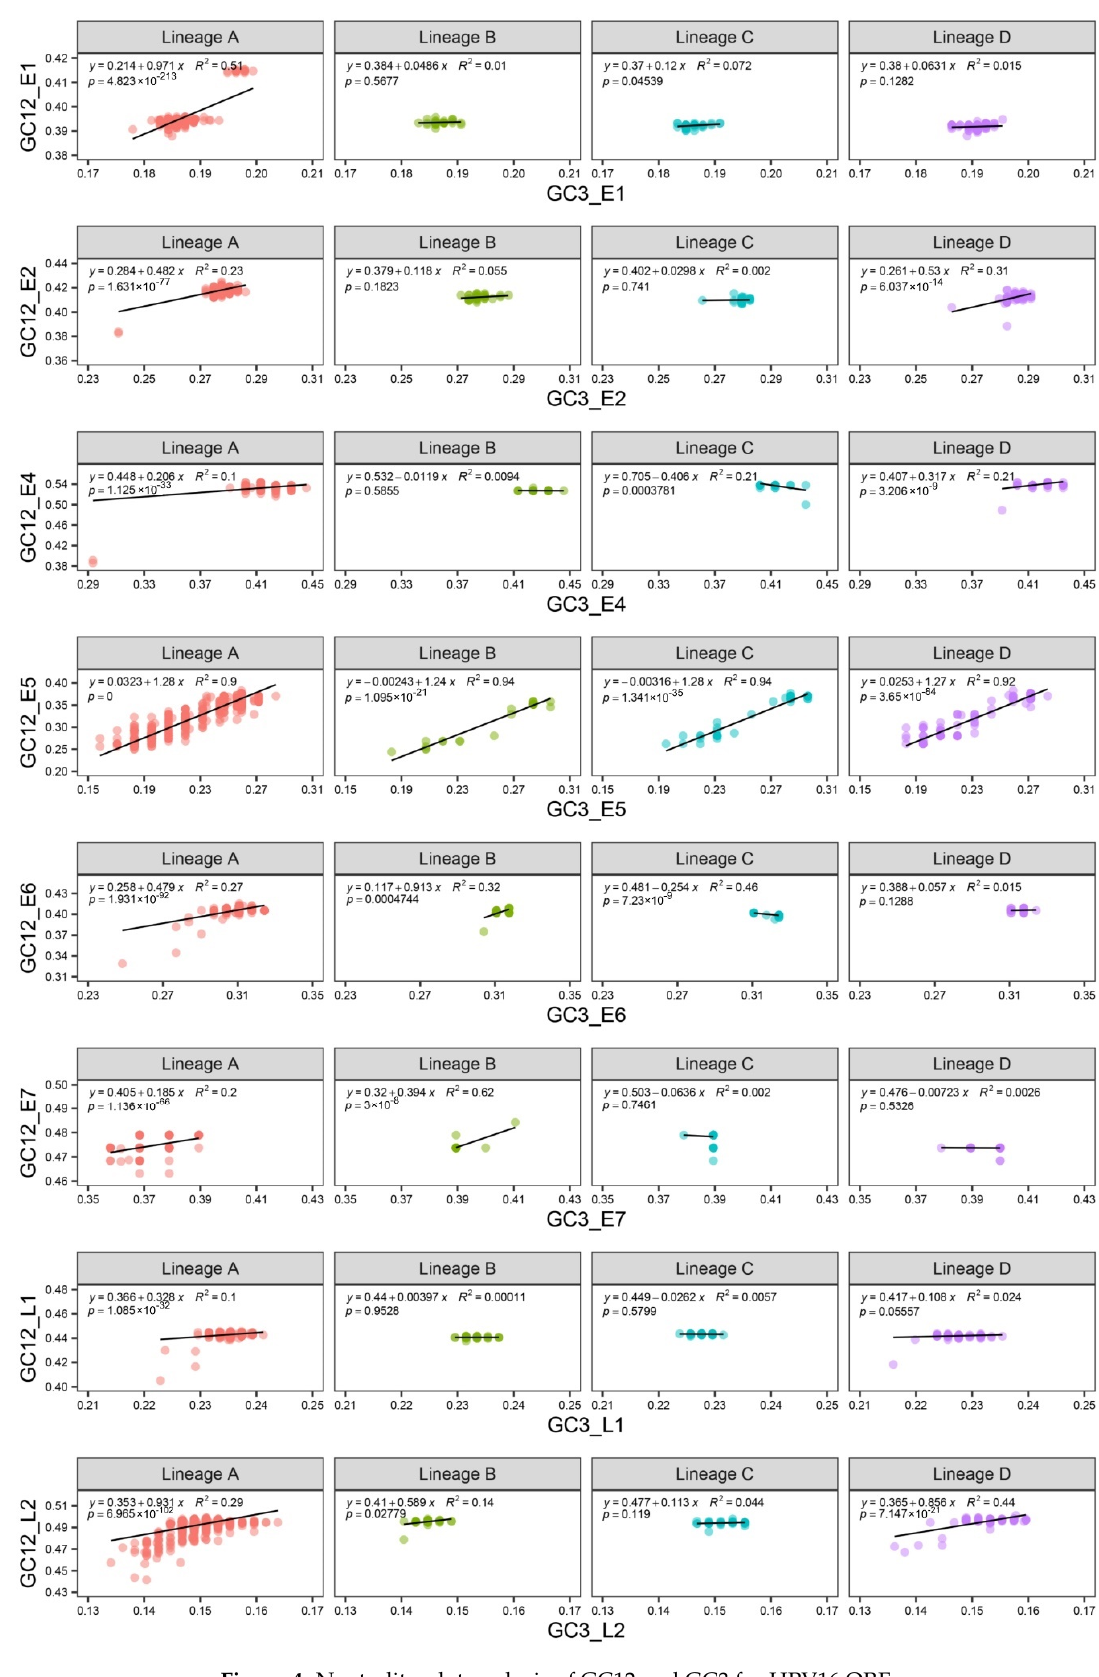
Figure 4. Neutrality plot analysis of GC12 and GC3 for HPV16 ORFs.